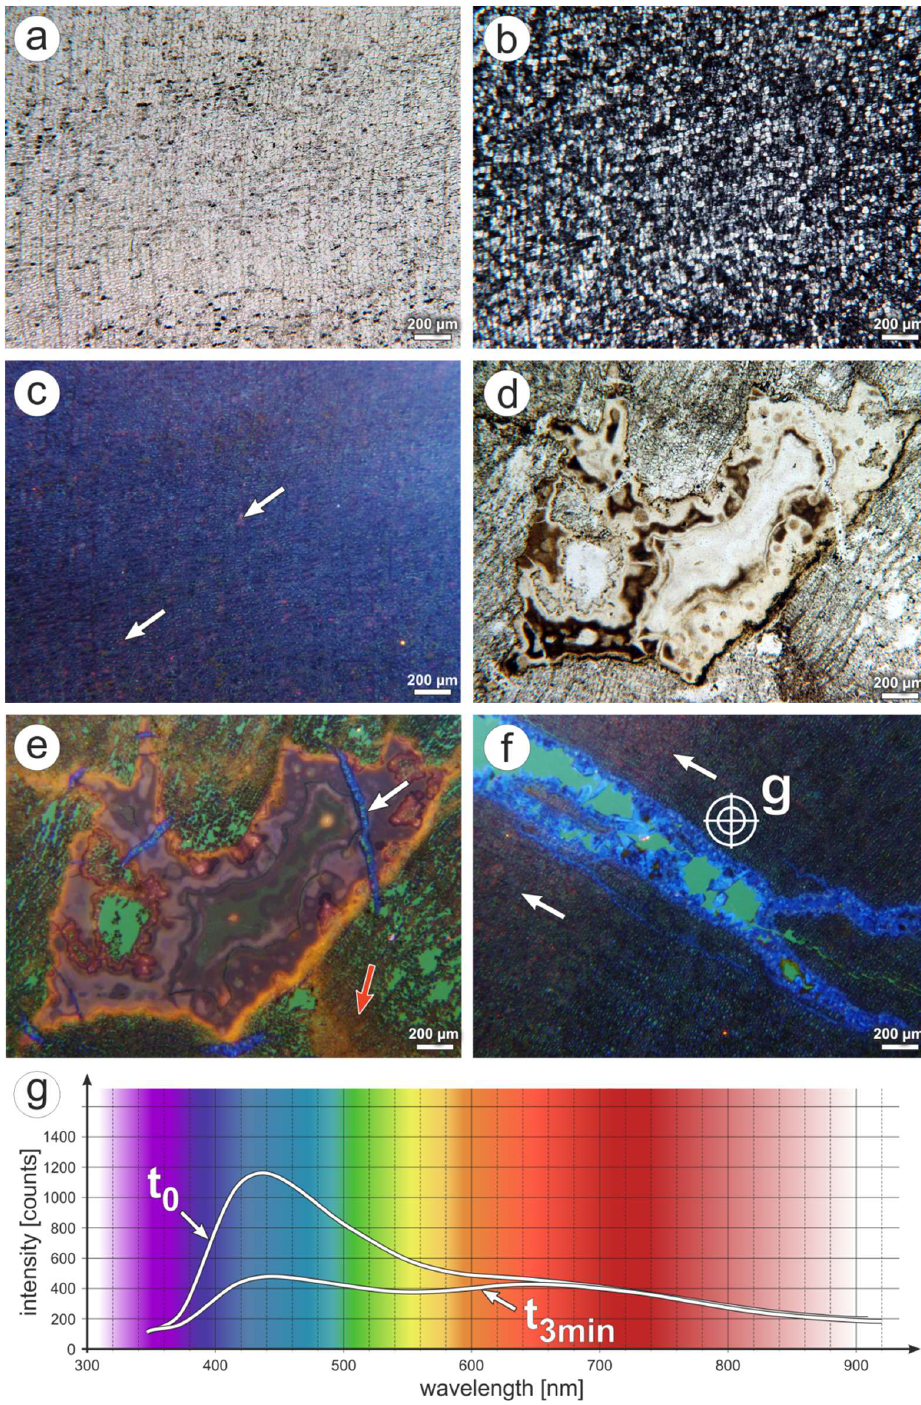
Figure 5. CL of K6563. ( a ) Silicified wood; PPL image. ( b ) Same view as in (a); XPL image. Note that quartz crystals comprise single tracheids or tracheid groups. ( c ) Same view as in (a), CL image, showing a short-lived blue CL interspersed with centers of red CL (arrows). ( d ) Agate-filled cavity; PPL image. ( e ) Same view as in (d); CL image. The agate possesses a brown CL, whereas surrounding intercellular space is filled by green-luminescing epoxy. Fillings of tight fractures dissecting the agate have a blue CL (white arrow). Neighboring areas show a yellow CL (red arrow). ( f ) Fracture filled by euhedral quartz displaying a short-lived blue CL; CL image. Note diffusively occurring red CL in cell lumina (arrow). ( g ) CL spectra taken at ( f ). Note decreasing intensity of blue CL after three minutes of irradiation, whereas red CL remains constant.